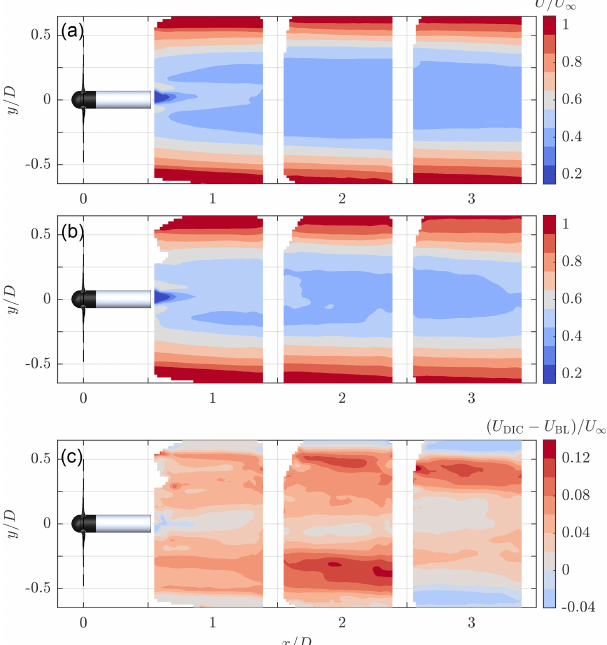
Figure 7. Contours of the streamwise velocity component U/U ∞ in the wake of the turbine at hub height ( z/D = 0), operating with baseline control (a) and DIC ( St = 0 . 24) (b) . The difference in ve- locity field between the two control methods is visualized in (c)